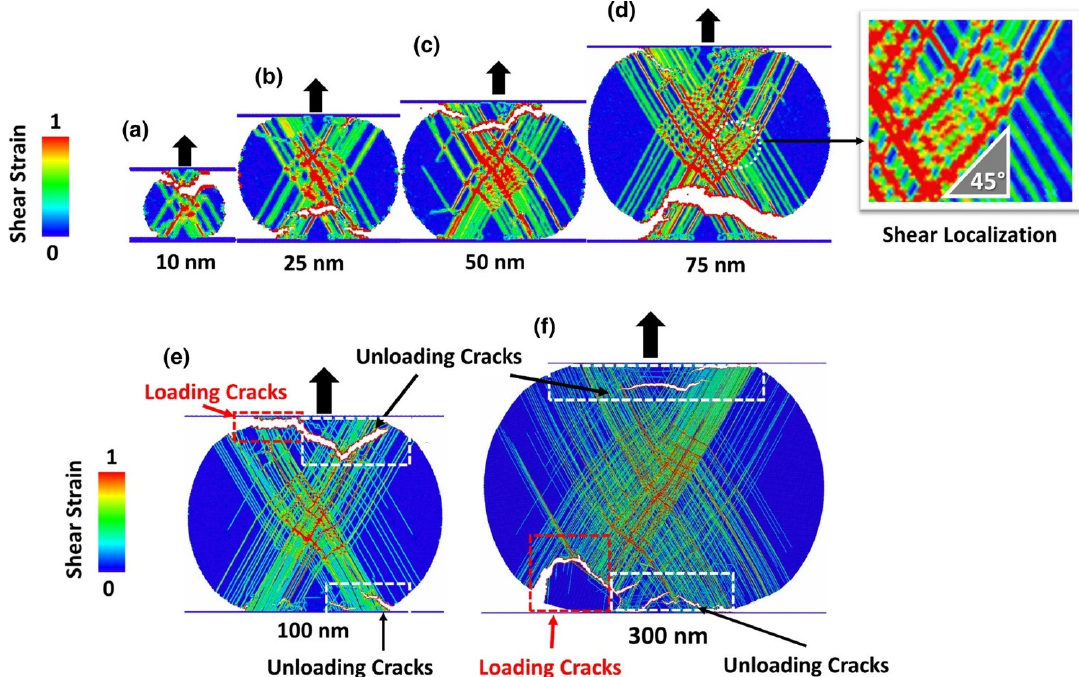
Figure 20. Simulated deformation patterns after compression loading and unloading (deformation history) by Von Mises shear strain fields inside the TiO 2 particles for different initial diameters of (a) 10 nm, (b) 25 nm, (c) 50 nm, (d) 75 nm, (e) 100 nm and (f) 300 nm. The strain pattern reveals (i) localized plastic deformations along the slip systems and (ii) shear localization in an orientation relation of 45° with respect to the loading direction. [40].